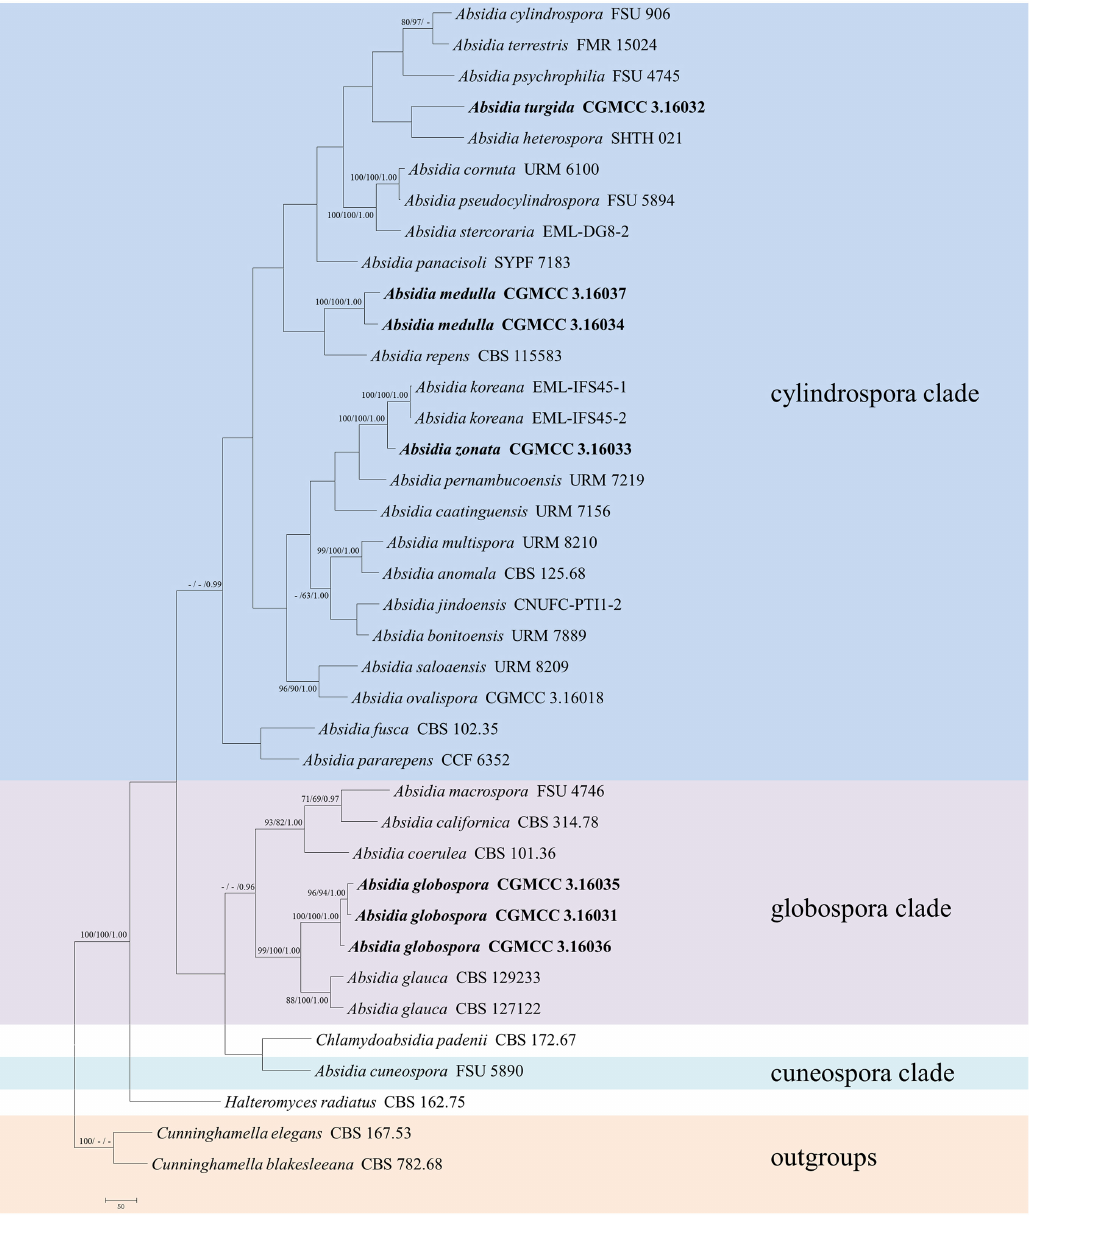
Absidia medulla T.K. Zong & X.Y. Liu, sp.